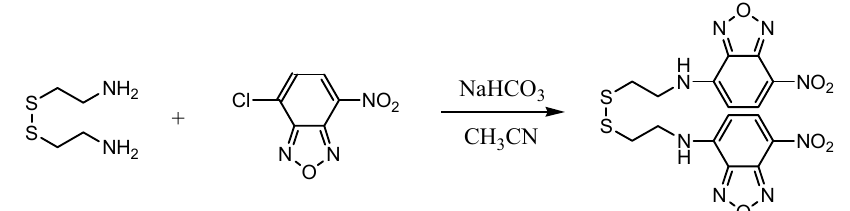
Figure 1. Chemical synthesis of the NBD-derivative of cystamine.